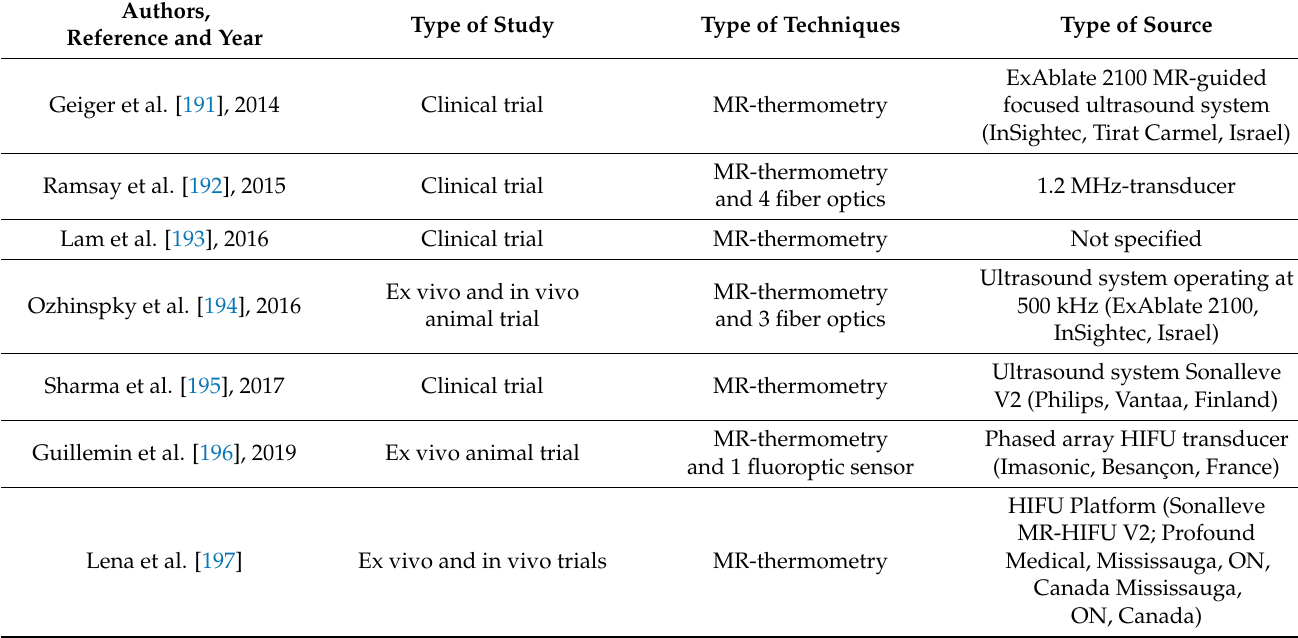
Table 5 summarizes studies performing temperature monitoring during HIFU in bone. Table 5. Studies related to temperature monitoring during HIFU ablation in